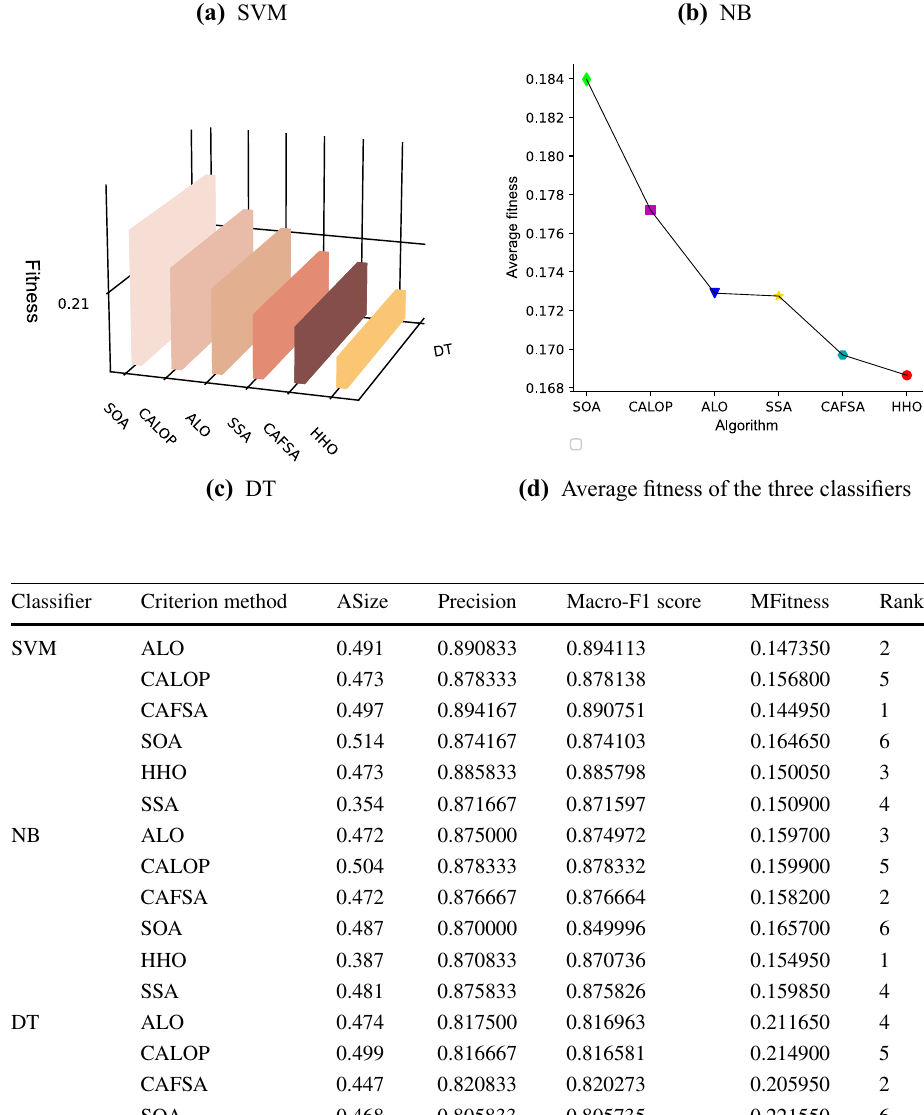
Fig. 15 Comparison of different feature selection algorithms on ChnSenticorp_Hotel dataset